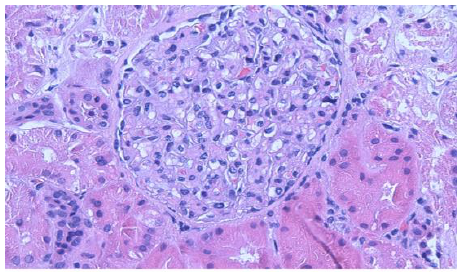
Figure 1. Light microscopy of kidney biopsy demonstrates normal mesangial cellularity (H&E 200 ×).